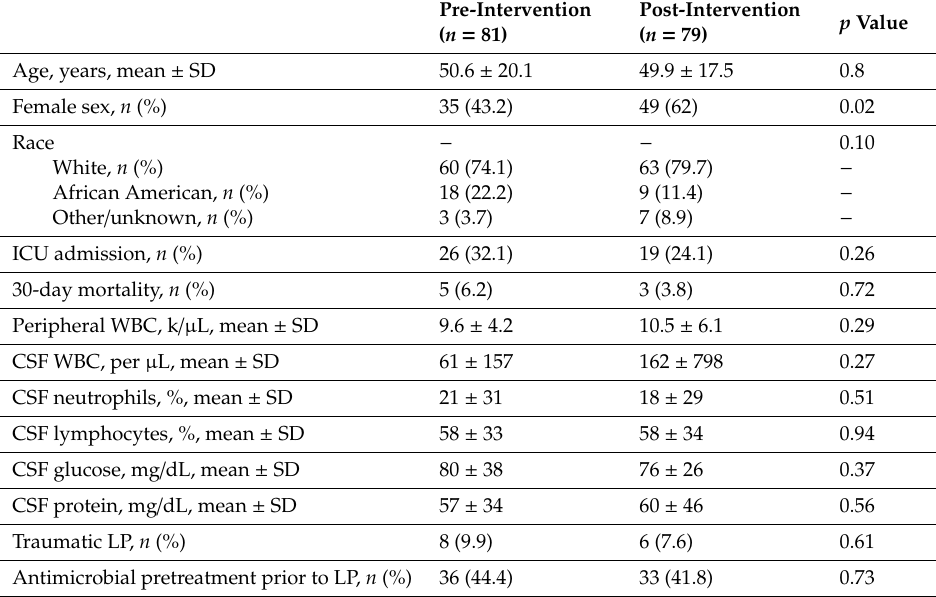
Table 1. Demographics and Baseline